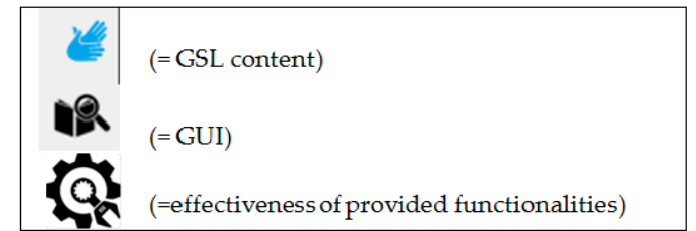
Figure 13. Emoticon-based Likert Scale used to collect young deaf user experience results.